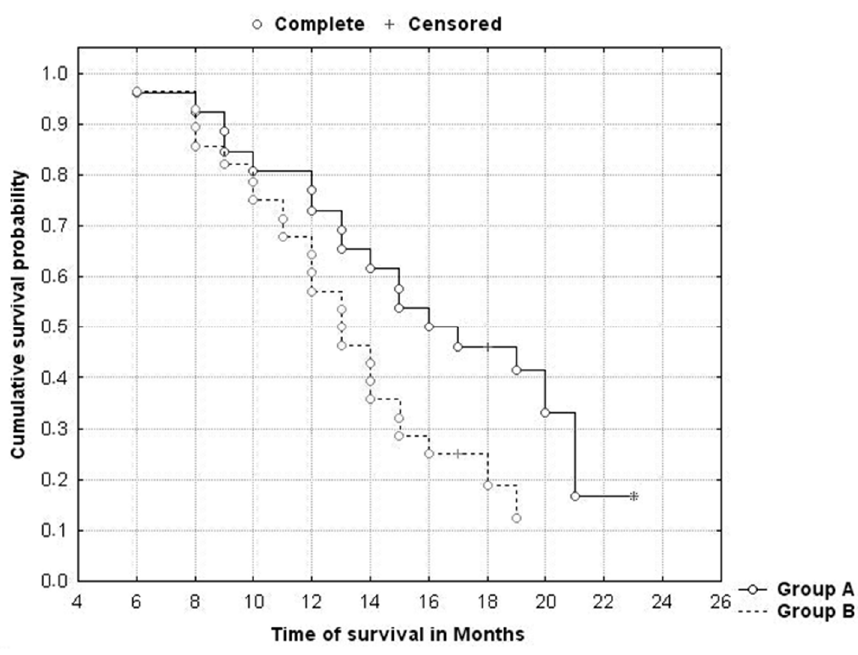
Figure 4. Kaplan–Meier survival analysis and long-rank test were performed to evaluate the OS between the two groups. p < 0.05 was considered significant.